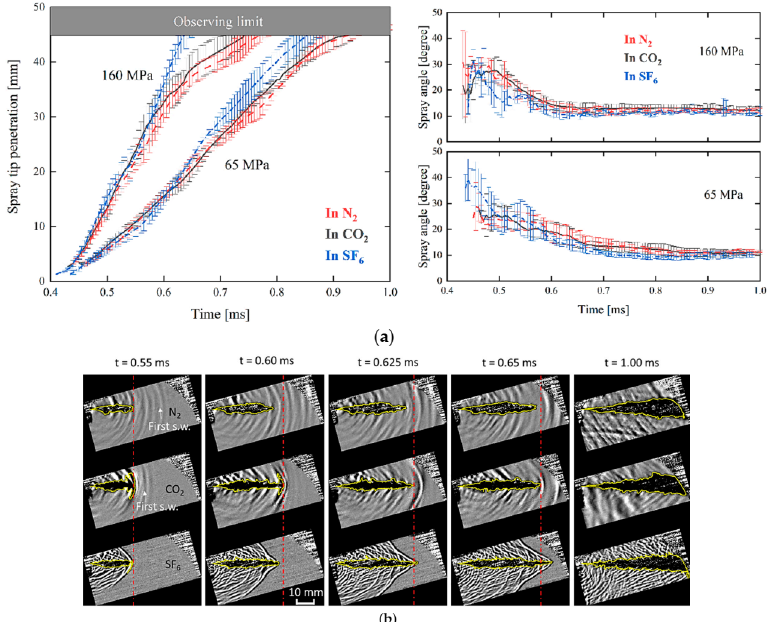
Figure 11. Shock wave generation e ff ect on the spray penetration and spray angle ( a ), and a sequence of spray images at 160 MPa ( b ). Ambient gas conditions: 297 K and 9.0 kg / m 3 . The red dash-dot line represents the spray leading edge of CO 2